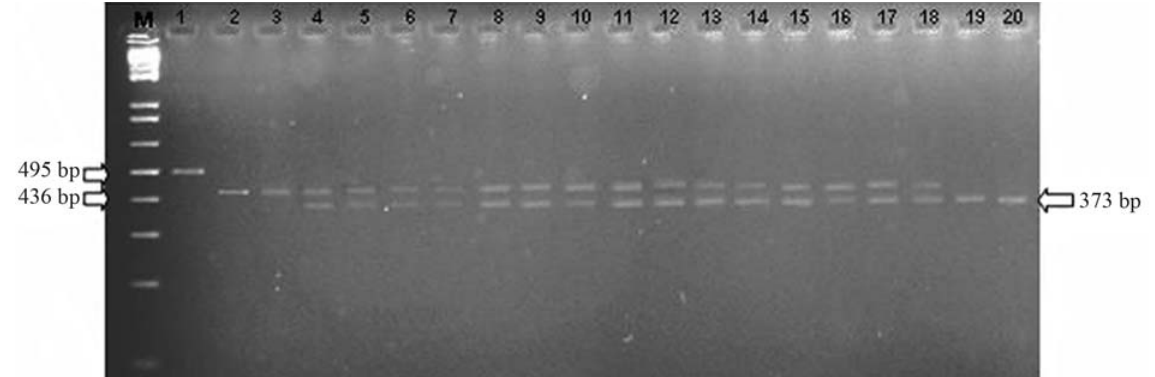
Figure 1 - Hae III-RFLP of CSN2 exon VII allows identifying bovine milk added to bubaline milk in mozzarella cheese. Lane 1, undigested 495 bp PCR product;lanes2to20,bubaline(436bp)andbovine(373bp)HaeIII-RFLPsobtainedfrommozzarellacheesecontaining0to100%bovinemilk;concen- trations of bovine milk: 0% (lanes 2 and 3), 1% (lanes 4 to 6), 2% (lanes 7 to 9), 5% (lanes 10 to 12), 8% (lanes 13 to 15), 12% (lanes 16 to 18), and 100% (lanes 19 and 20). M, 1 kb Plus DNA Ladder. Restriction fragments less than 80 bp cannot be visualized on this 3% agarose gel (see Figure